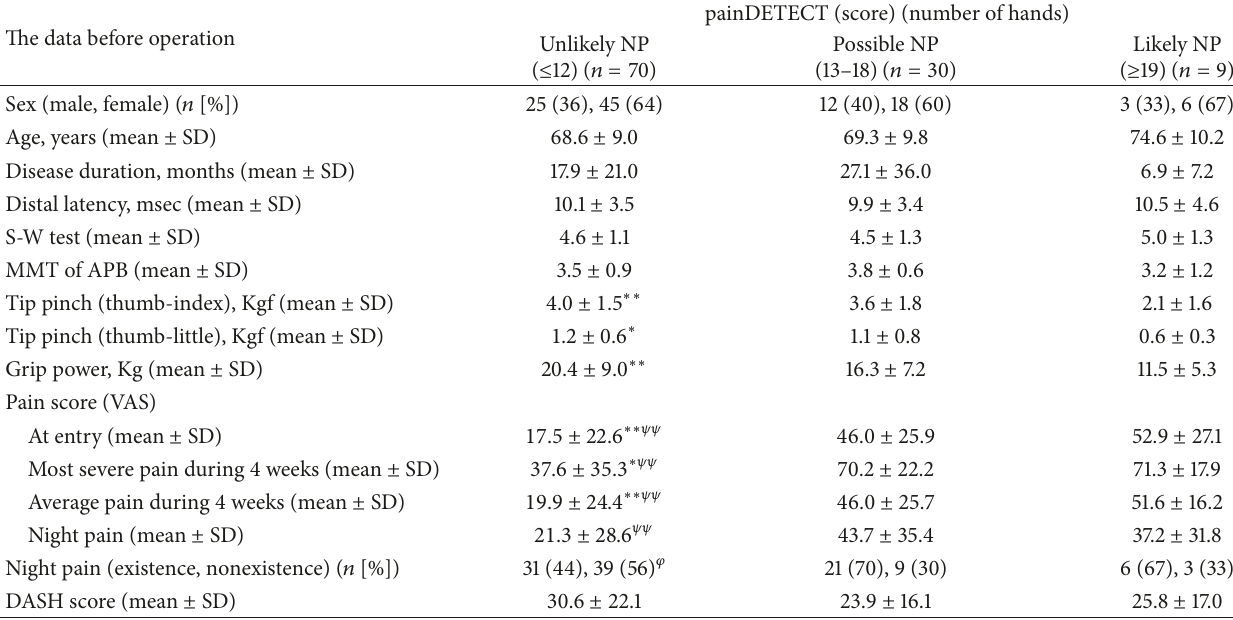
Table 4: The relationship between the painDETECT scores and clinical characteristics before surgery. The data before